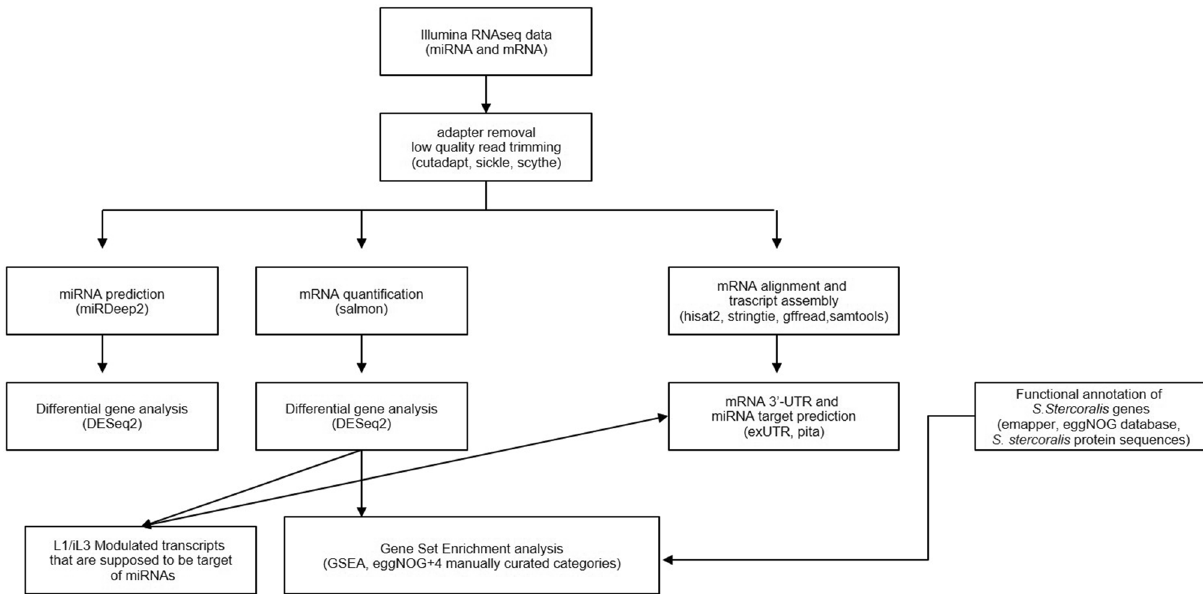
Figure 4. Flowchart of mRNASeq and miRNASeq bioinformatic